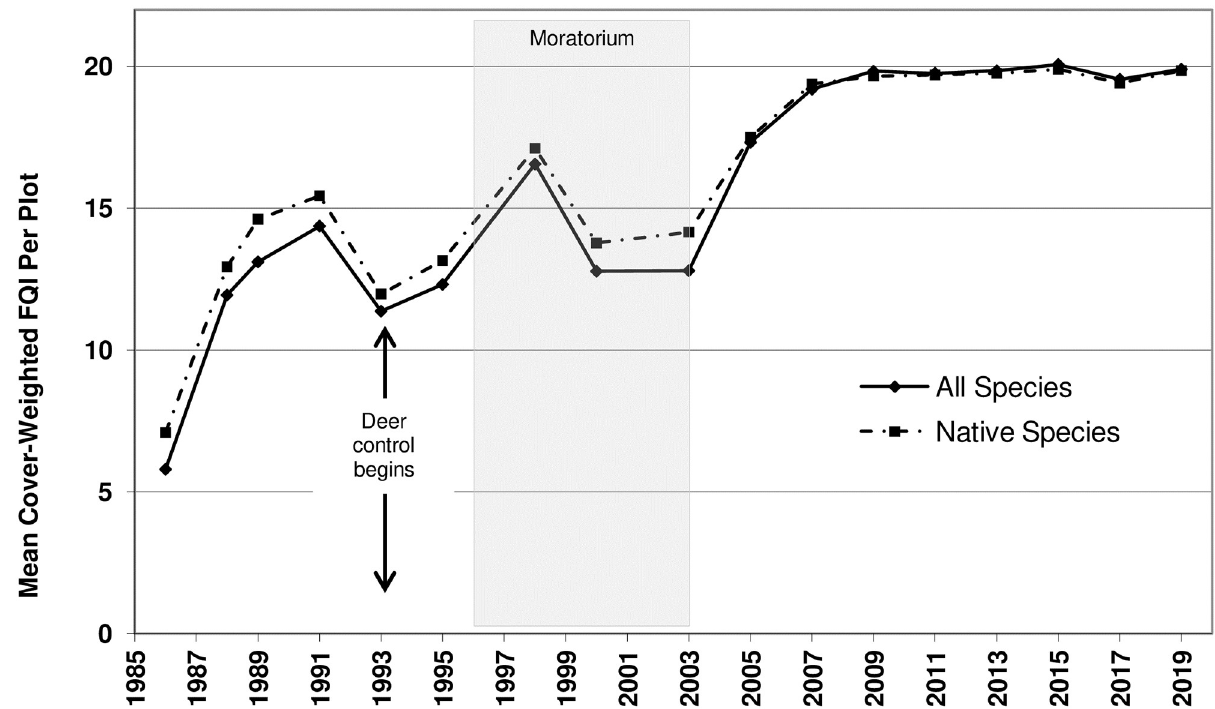
Fig 4. Mean Cover-weighted Floristic Quality Index (FQI) per plot. Time series analysis used the mean value of all species for each year sampled. Arrows represent the onset of deer culling, which continued thereafter. Shaded area represents the vegetation management moratorium years.